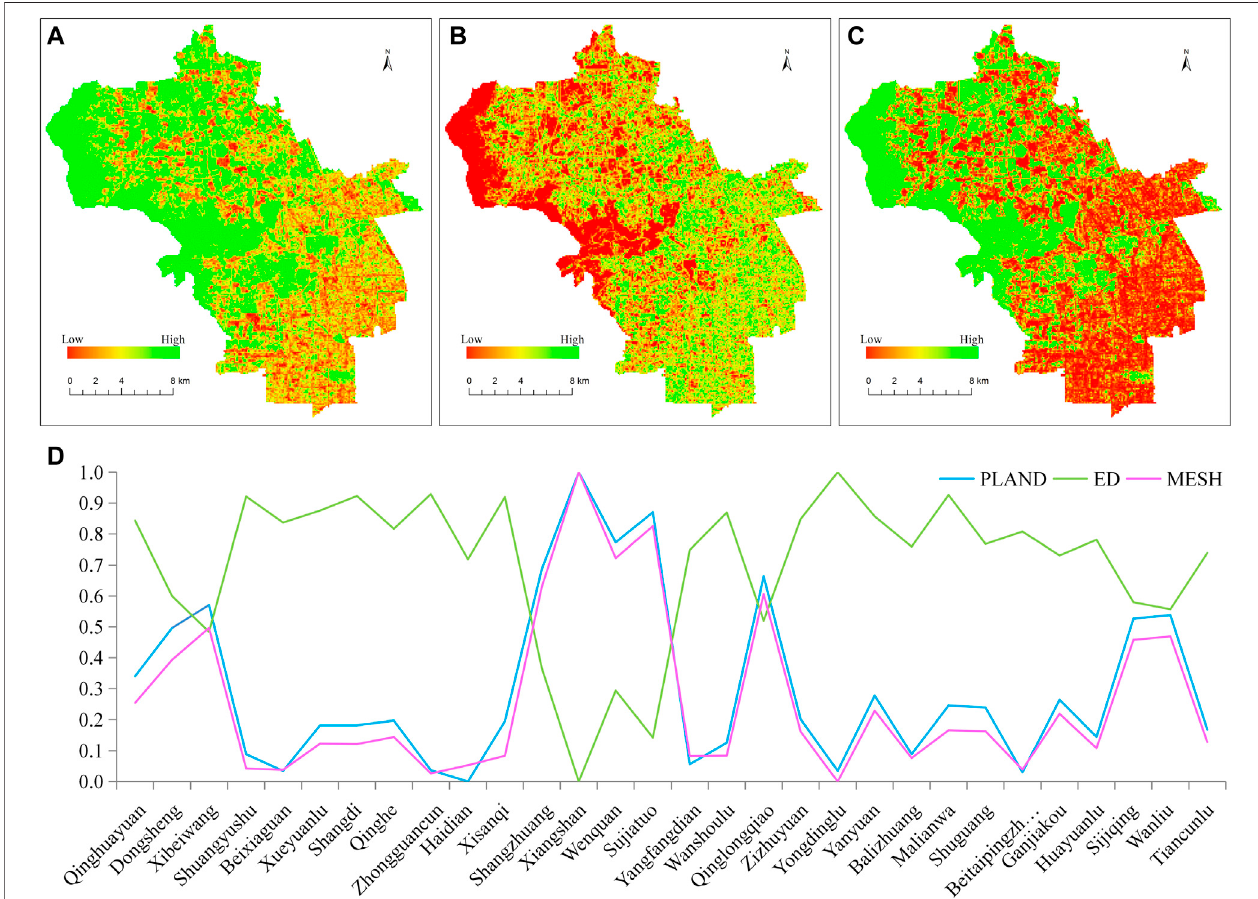
FIGURE 5 | The spatial distribution of landscape metrics PLAND (A) , ED (B) , and MESH (C) , and sub-district-wise normalized landscape metrics (D) .